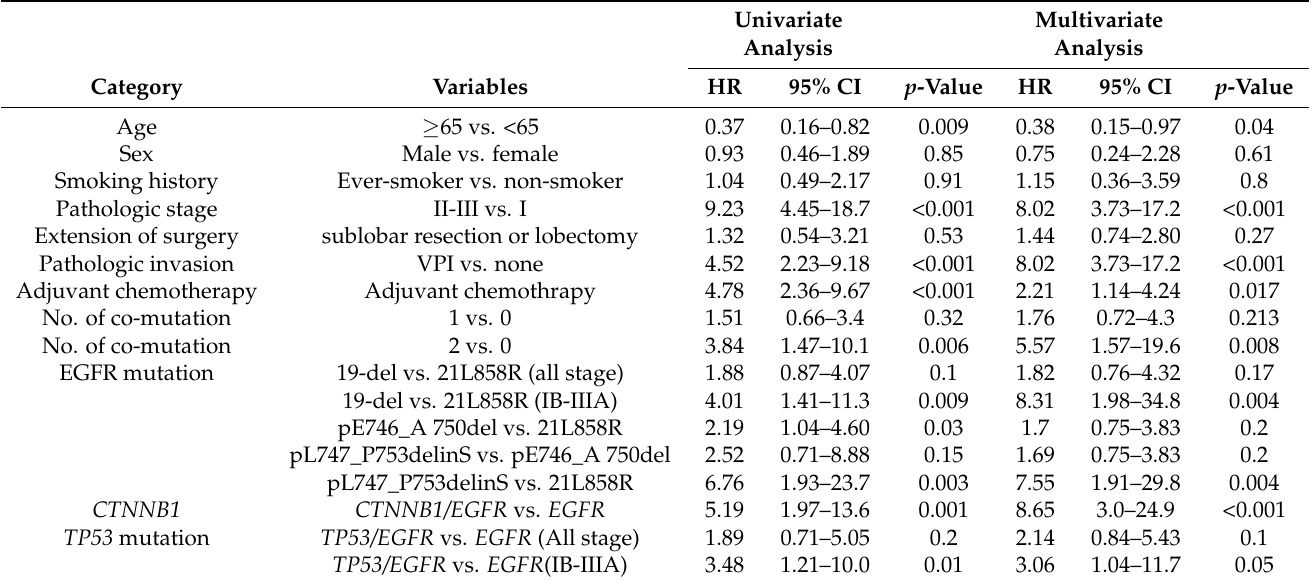
Table 2. Prognostic factors for recurrence based on multivariate analysis of resected EGFR-mutated lung adenocarcinoma.